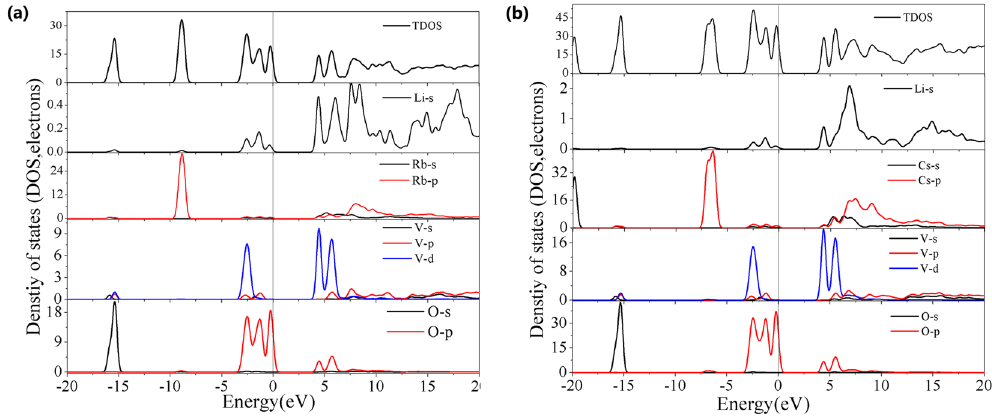
Figure 5. Partial density of states (PDOS) and total density of states (TDOS) of RLVO ( a ) and CLVO ( b ). The Fermi level is set as E = 0